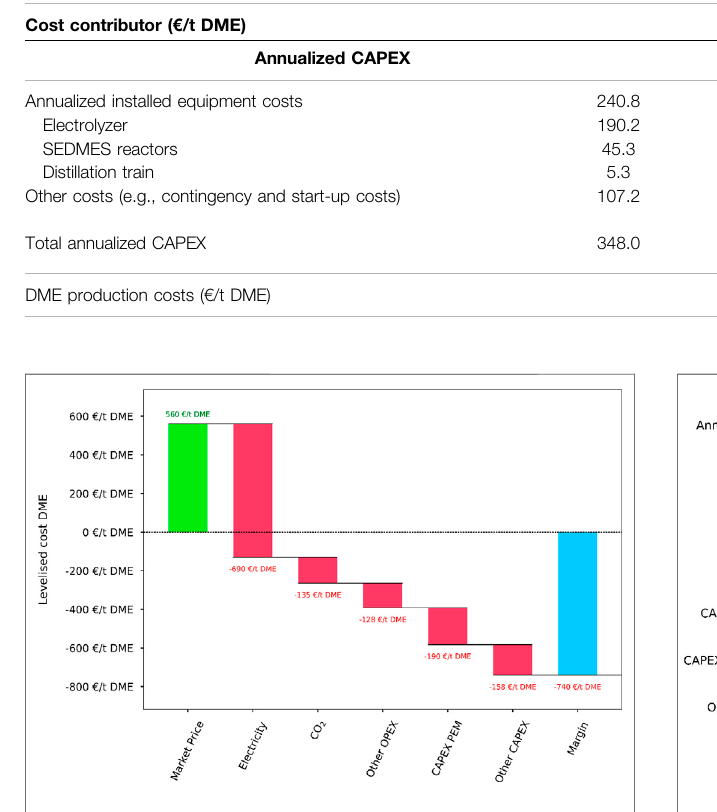
FIGURE7| Sensitivityanalysisonthemaincostcontributingfactorstothe power-to-X technology SEDMES process. H 2 is produced by PEM electrolysis and reacts with captured CO 2 to produce DME. Ann Prod, annual production scale; C CO2 , carbon dioxide cost; C El , electricity cost; Eff PEM , ef fi ciency of the PEM electrolyzer; CAPEX PEM , capital costs electrolyzer; CAPEX SEDMES , capitalcosts SEDMESunit.Blueand green barindicatelowerand higher values compared to the base case,